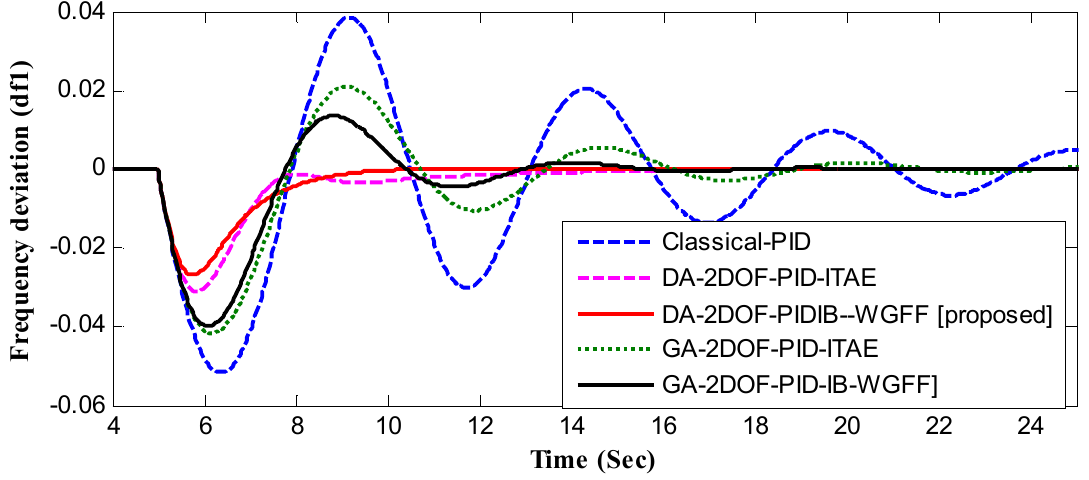
Figure 29. Frequency deviation ( Δf (cid:2869) ) of area 1 under parameter perturbations.